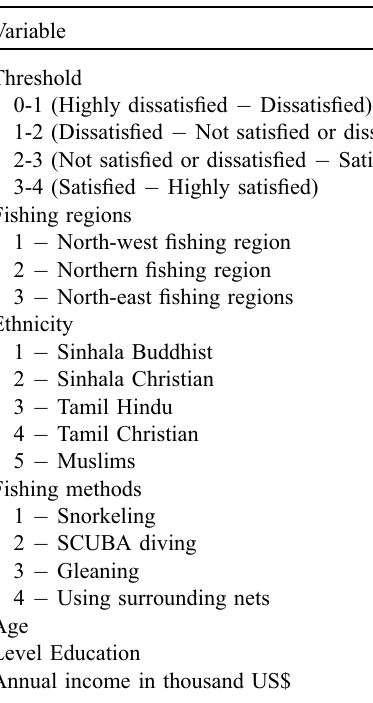
Table 8. Output of parameter estimates of the ordinal regression model construct to analyze the level of satisfaction of sea cucumber fi shers on their buyers in the three coastal regions of Sri